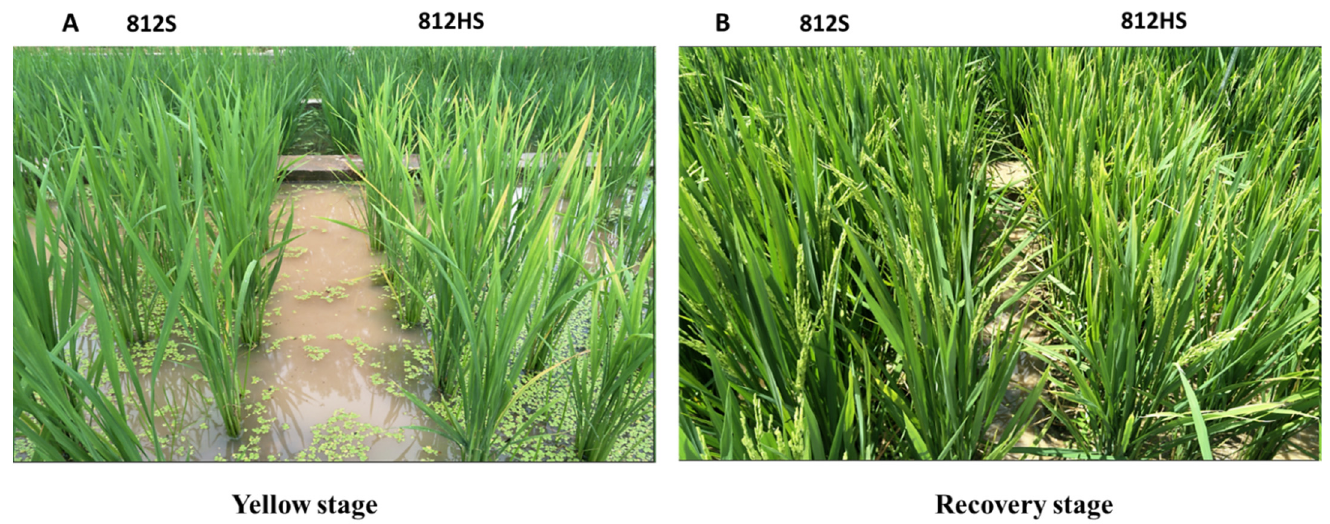
Figure 1. The phenotypic analysis of the rice wild-type 812S and mutant 812HS in the field during yellow stage ( A ) and recovery stage ( B ).